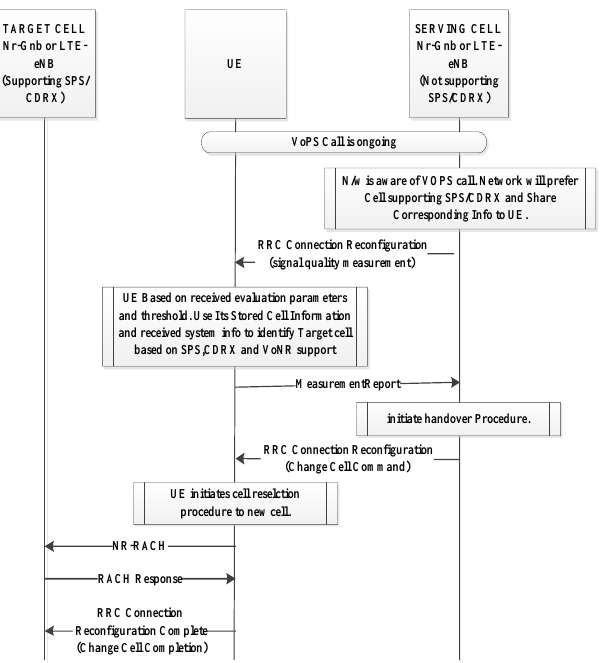
Fig. 9. Extended Approach for Connected Mode